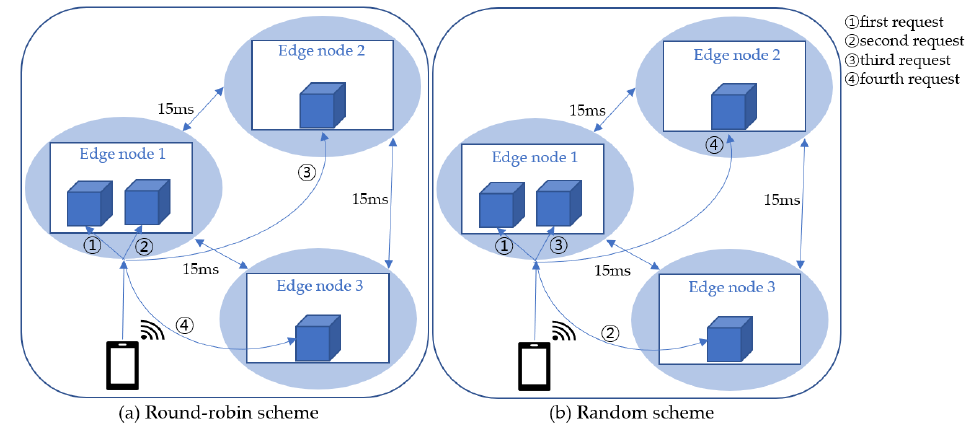
Figure 2. Load-balancing schemes in KubeEdge.